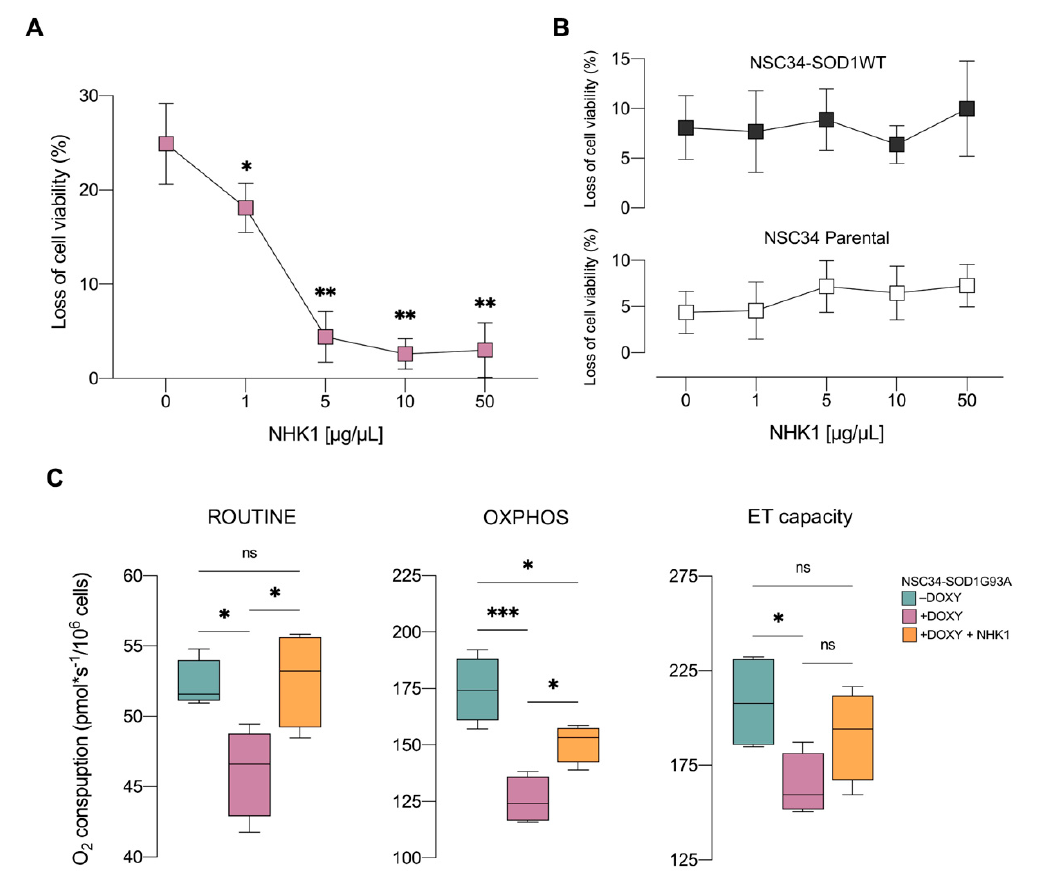
Figure 2. NHK1 counteracts the loss of cell viability and the respiration deficit induced by SOD1 G93A expression. ( A ) Cell viability assay performed in +DOXY NSC34-SOD1G93A in presence of increasing concentration of NHK1 peptide. ( B ) Cell viability control experiments performed in +DOXY NSC34-SOD1WT and in NSC34 parental cells in the presence of increasing concentration of NHK1 peptide. Data are expressed as means ± SD of n = 3 independent experiments and analyzed by t -test, with * p < 0.05 and ** p < 0.01 related to untreated NHK1 sample. ( C ) Quantitative analysis of the oxygen consumption of not permeabilized cells (ROUTINE) and of permeabilized cells (OXPHOS and ET capacity). +DOXY NSC34-SOD1G93A cells, previously treated with NHK1 peptide or DMSO, were compared with untreated − DOXY (control). Data are expressed as median or means ± SD of n = 4 independent experiments and analyzed by one-way ANOVA, with * p < 0.05 and *** p < 0.001; ns, not significant.